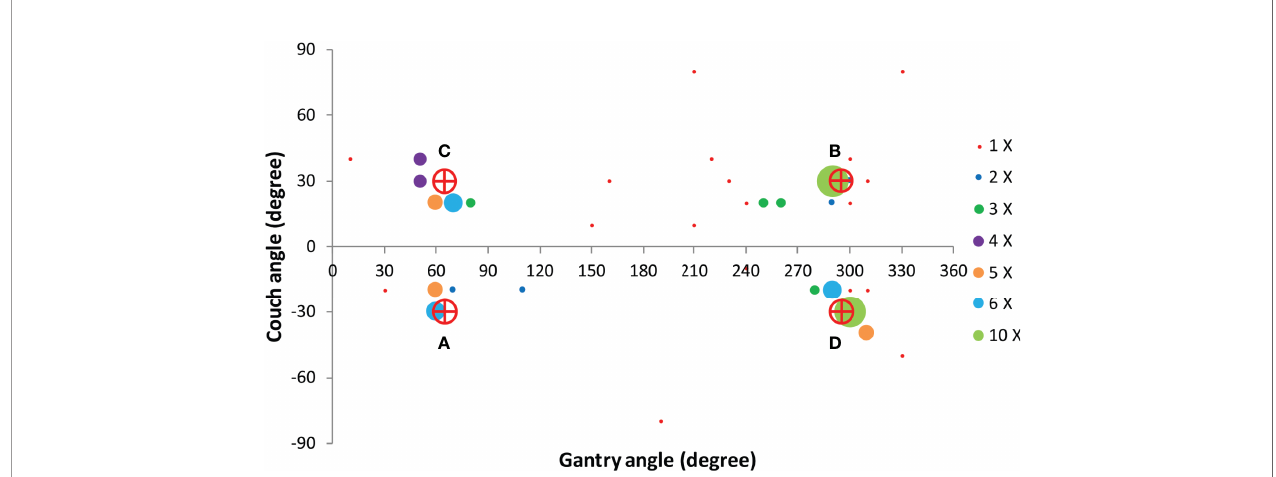
FIGURE 2 | Angular distribution of the 100 non-coplanar IMRT beams in the VMAT+5 plans of the 20 study patients. Based on these results four principle beam directions A = (65°, -30°), B = (295°, 30°), C = (65°, 30°) and D = (295°, -30°) were derived to develop the fi nal class solution for